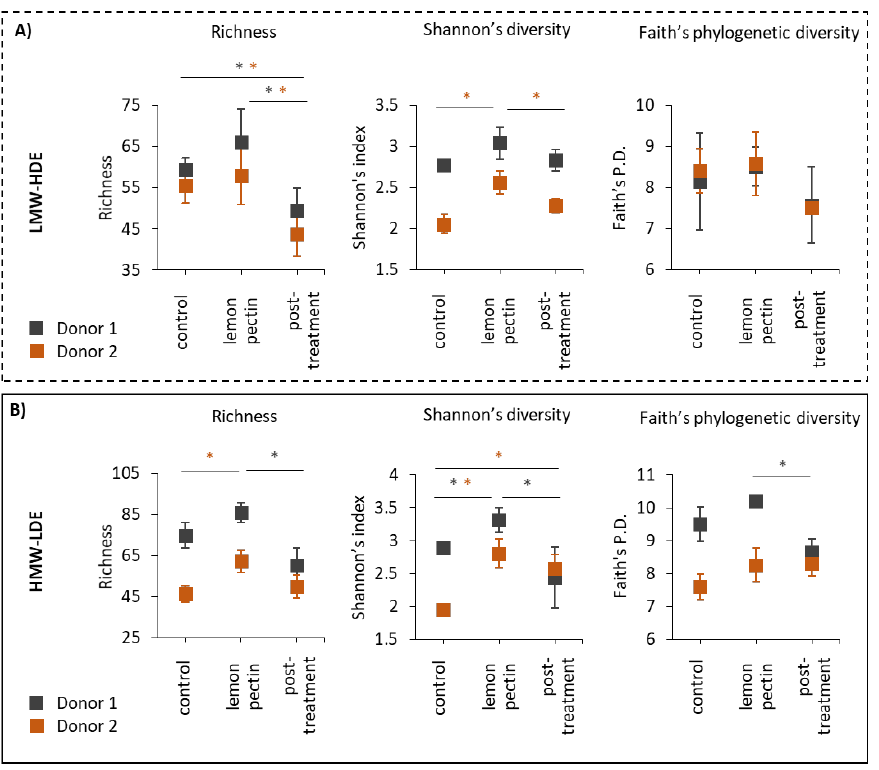
Figure 1. Alpha diversity in terms of richness, Shannon’s diversity, and Faith’s Phylogenetic diversity (Faith’s P.D.). Statistically significant changes are indicated in the figure with an asterisk (*) symbol. ( A ) LMW-HDE lemon pectin; ( B ) HMW-LDE lemon